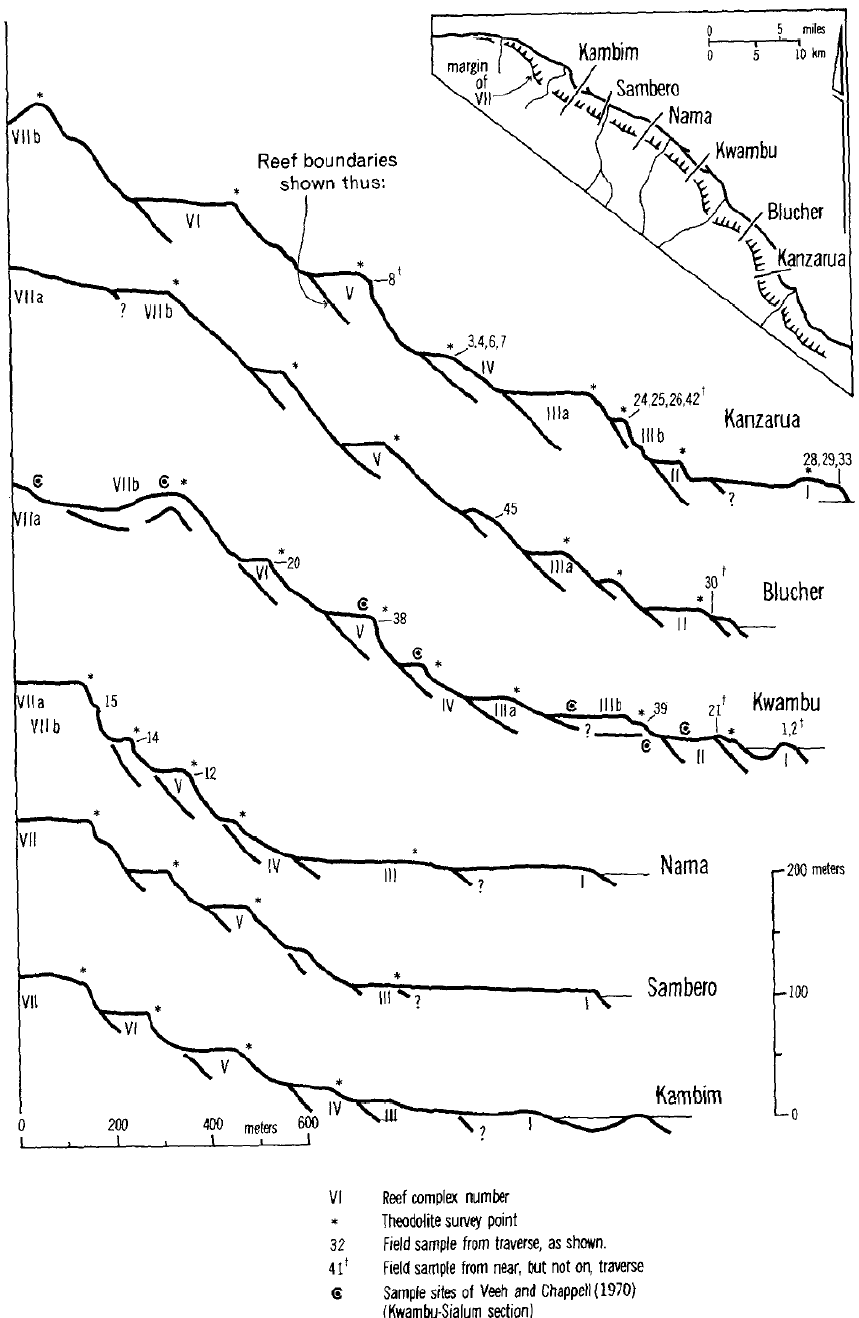
Figure 29. Emerged reef terraces on Huon Peninsula. Reef complexes I to VII are shown by Roman numerals. Sample numbers are shown as close as possible to their collection localities (from Bloom et al.,